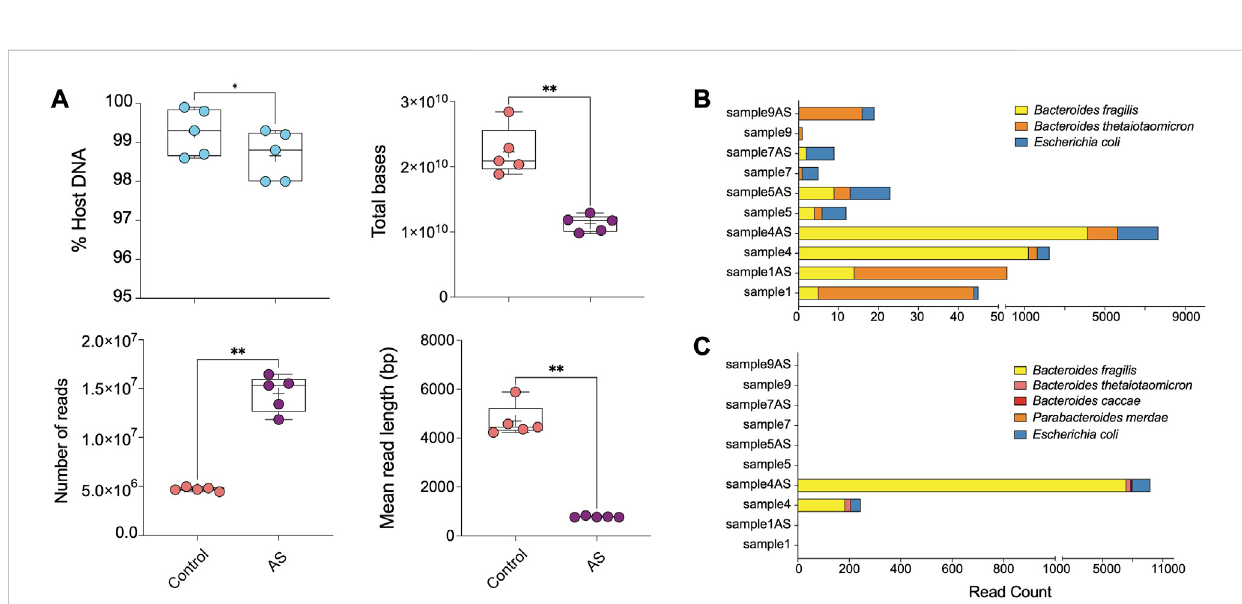
FIGURE 4 ONTASenrichessequencingyieldandthenumberofsequencedbacterialreadsfrombiopsies. (A) Thecomparisonbetweenthepercentageofhost DNAinsamplessequencedwith(AS, n =5)andwithout(Control, n =5)theadaptivesamplingapproachwasbasedonmultipleparameters,includingtotal bases, the total number of reads, and the mean read length (base pair). The bar plots show the most abundant enriched taxa classi fi ed from (B) reads and (C) metagenomic assemblies for samples sequenced on ONT with and without adaptive sampling. Samples ending with “ AS ” annotation are sequenced with the ONT AS approach, and the rest are without this approach. Asterisks for p -values: * p < 0.05, ** p < 0.01, *** p < 0.001, and **** p <